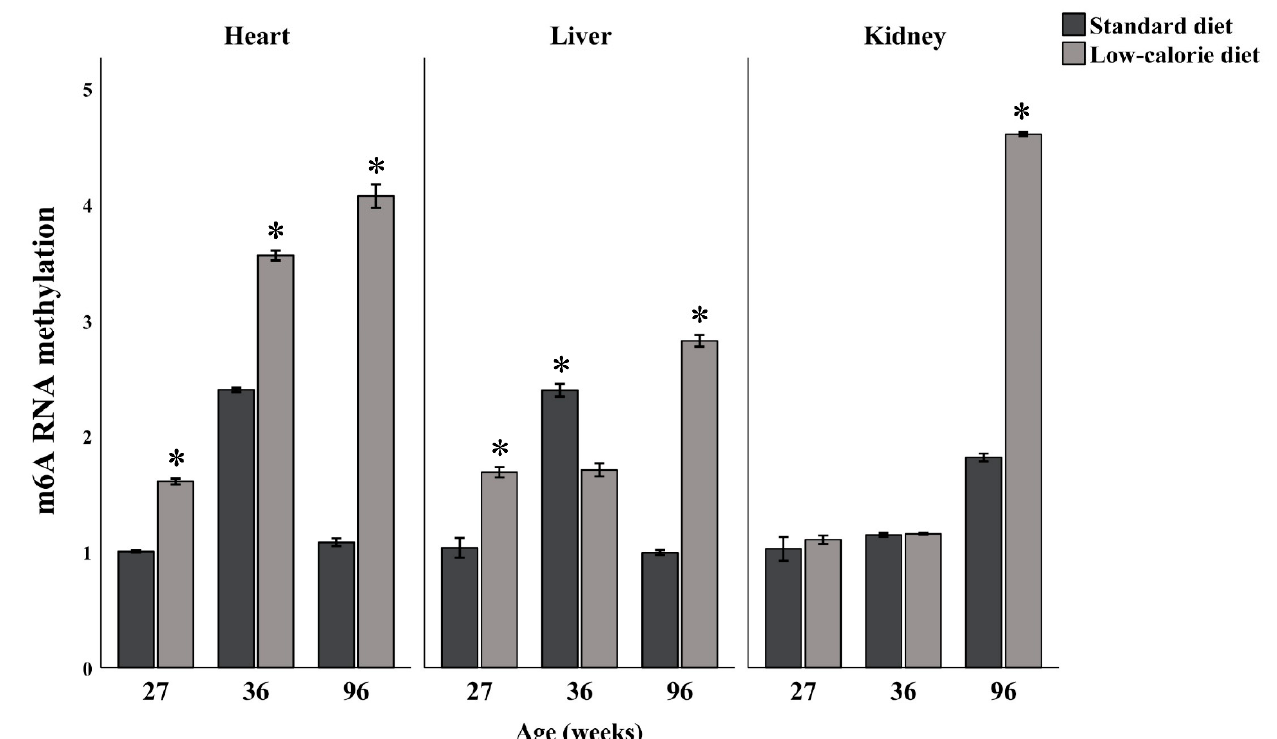
Figure 1. Global RNA methylation levels in the heart, liver, and kidney from rats of 27, 36, and 96 weeks of age, fed with standard and low-calorie diets. The values represent the mean of three inde- pendent triplicate experiments with standard deviation. * p < 0.001 (Welch’s test Bonferroni ad- justed).